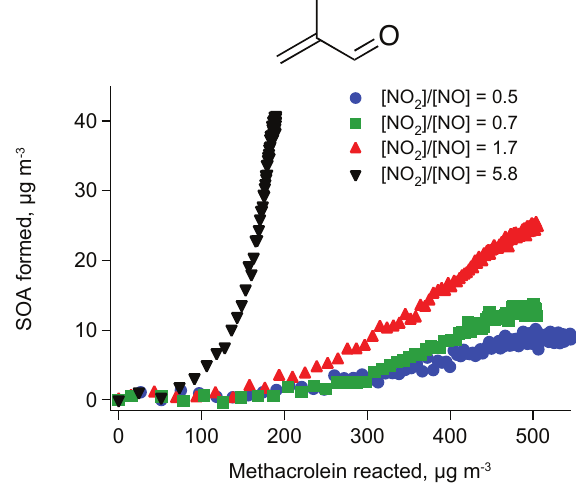
Fig. 4. Time-dependent SOA growth curves for acrolein photoox- idation. Similar to methacrolein photooxidation, NO 2 /NO ratios are computed from photochemical modeling (see Appendix). In the high-NO experiments (NO 2 /NO < 3), HONO was used as the OH precursor, and the NO 2 /NO ratio was varied by adding differ- ent amounts of NO or NO 2 . In the experiment in which NO 2 was added (red triangles), high levels of NO 2 depress OH concentra- tions, resulting in less acrolein reacted. Concentrations of NO did not drop as rapidly as in other high-NO experiments, leading to a lower NO 2 /NO ratio. In the high-NO 2 experiment (black triangles), CH 3 ONO was used as the OH